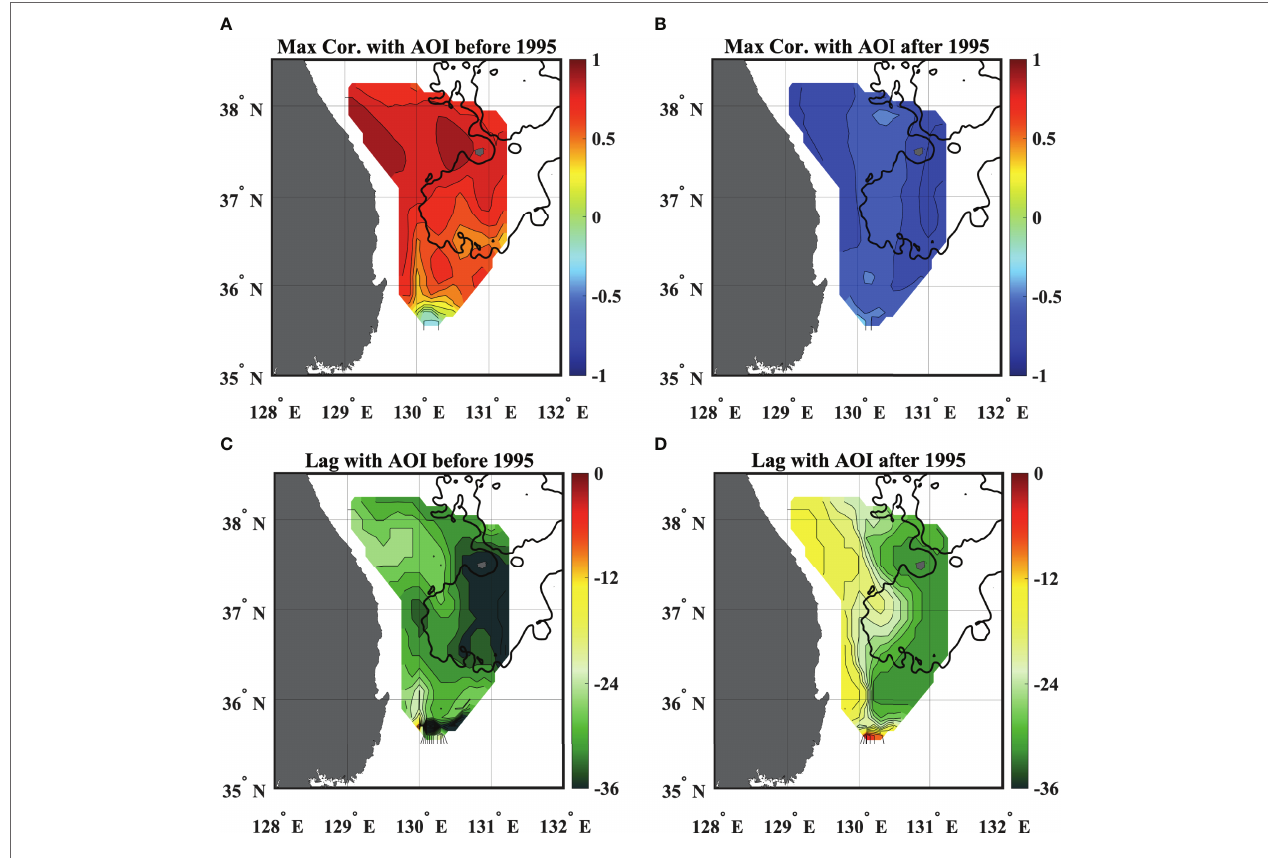
FIGURE 14 | Spatial maximum correlation map of the ESIW thickness with AOI (A) from 1965 to 1994 and (B) from 1995 to 2020. (C, D) Are showing the monthly lag where the maximum correlations in (A, B) are, respectively. Contour intervals are 0.1 in (A, B) and 2 months in (C, D)